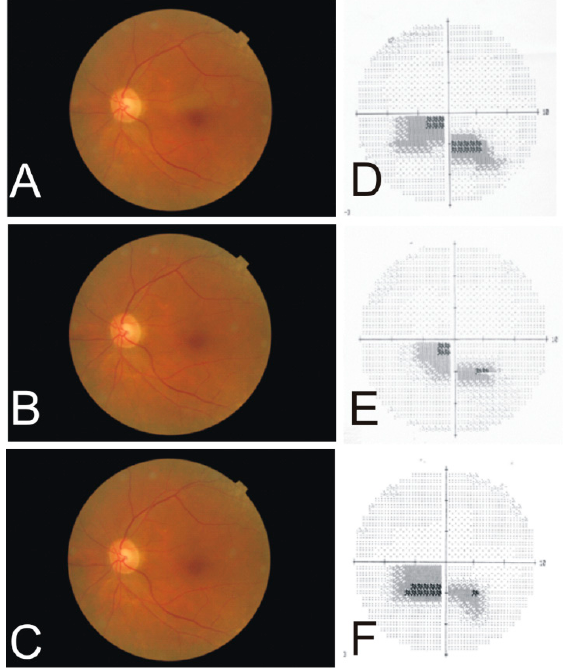
Figure 2. A series of fundus photographs and corresponding Humphrey visual fields (10–2) demonstrating the development of a cilio-retinal artery occlusion in the left eye of an 81-year-old female. The initial scotoma ( A , D ) in the inferior visual field improved somewhat after three months ( B , E ) but remained constant after four years ( C , F ).